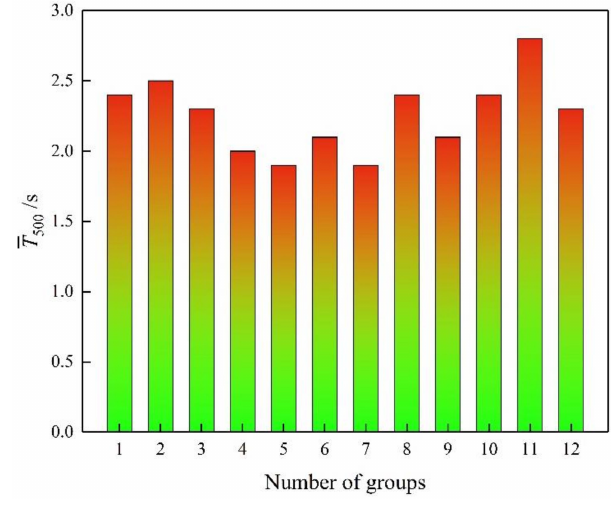
Figure 10. Statistical results of SCFFC T 500 .